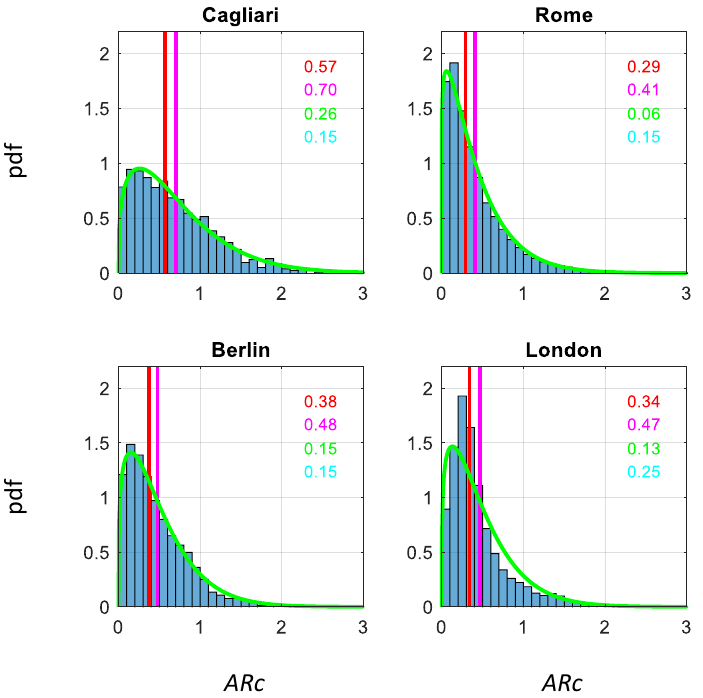
Figure 7. Pdf (ordinates) of ARc (abscissa) for each of the case studies; the red line highlights the average value, the magenta line the median value, the green line the best-fit Weibull distribution; on the legend, in red the average value, in magenta the median value, in green the most probable value of the best-fit distribution and in cyan the most probable value of the data.